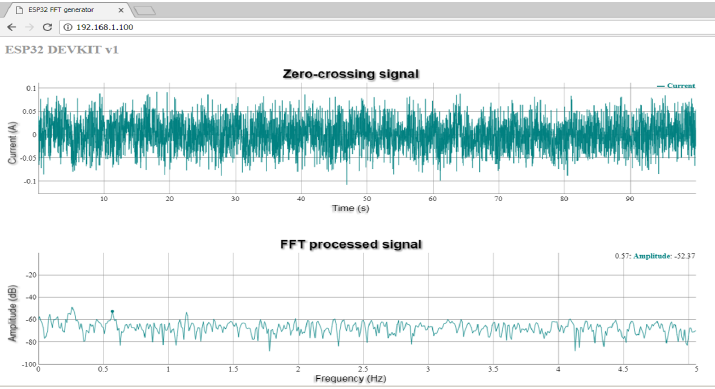
Figure 7. Reduced current envelope ( top ) and its spectrum ( bottom ) for the motor current in Test 1, generated in the built-in web server of the ESP32 device with the proposed approach.